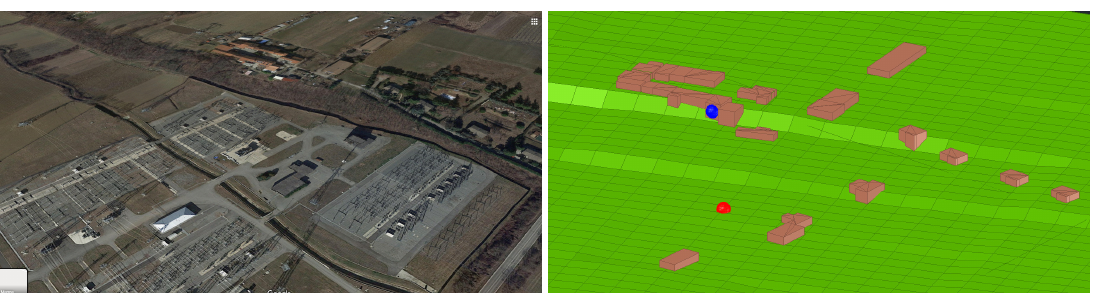
Figure 8. Left : area involved in the simulation for the fully validated case (Imagery c (cid:13) 2020 Google, Imagery c (cid:13) 2020 Maxar Technologies, Map data c (cid:13) 2020 Google). Right : digital terrain model with transformer TR4 indicated in red and the receiver in